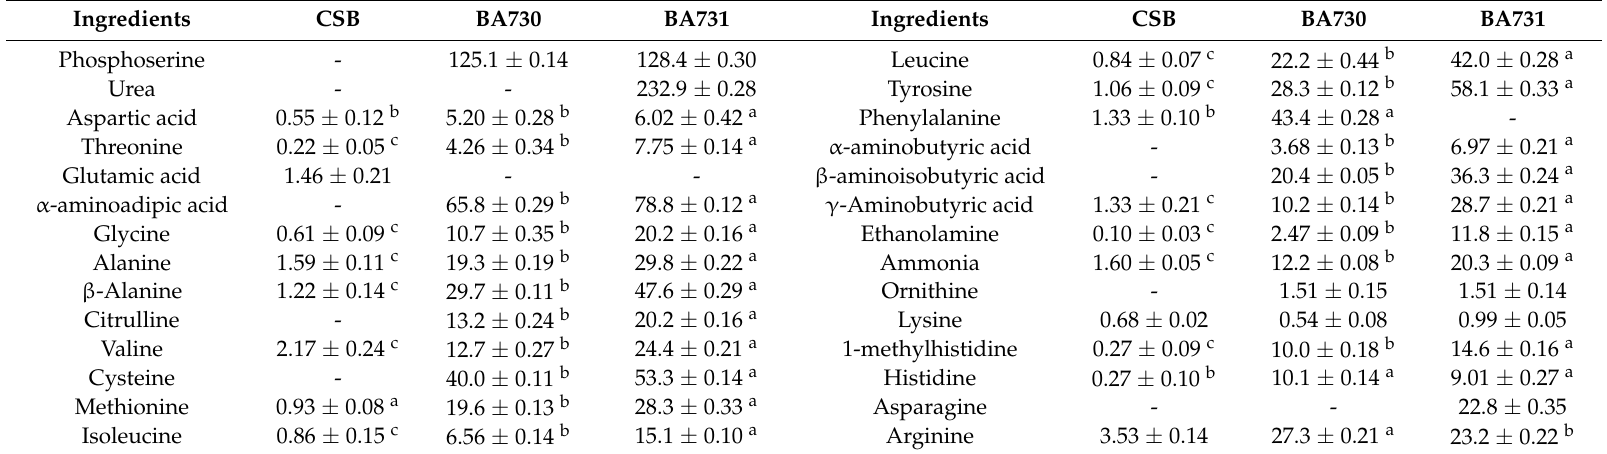
Table 3. Contents of free amino acids in water extracts of cooked soybeans and chungkookjangs made with B. amyloliquefaciens. (unit: mg/g dry soybean or